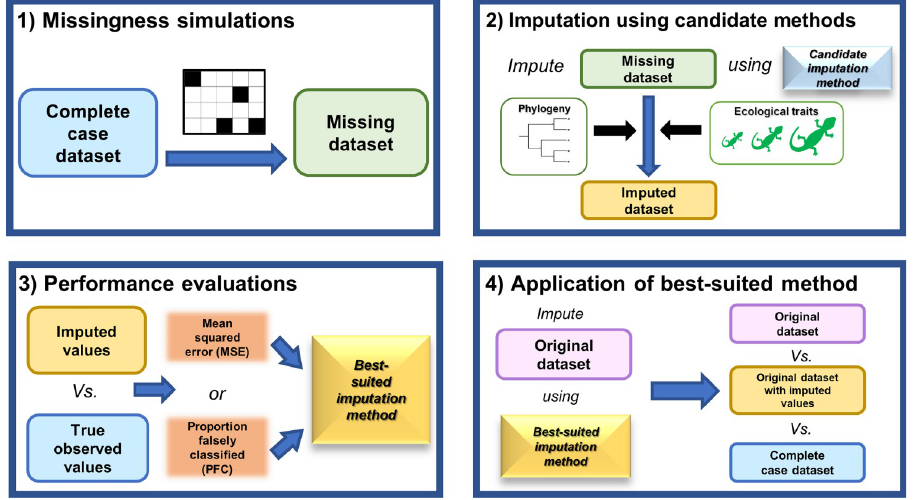
Fig 7. Workflow of the real data-driven simulation strategy. 1) Missing values are simulated in the near complete- case dataset under MCAR, MAR, and MNAR mechanisms. Missing dataset refers to the near complete-case dataset with simulated missing values; 2) imputation of simulated missing values using different candidate methods (with or without phylogeny); 3) identification of the best-suited method based on the performances (MSE and PFC) of the candidate methods. The imputed values from 2) are compared to the true observed values in the near complete-case dataset to derive MSE and PFC for numerical and categorical traits, respectively. Note that the “true observed values” refer to the trait values reported in the source Meiri (2018) dataset [16,17]. These values are assumed to contain a negligible amount of measurement error in this context and provide a close representation of the true biological values for squamates. MSE and PFC are averaged across 100 replicates; and 4) application of the best-suited imputation method to the original target dataset with missing values. Original data, original data with imputed values, and complete-case data characteristics and distributions are compared to assess how imputation impacts dataset